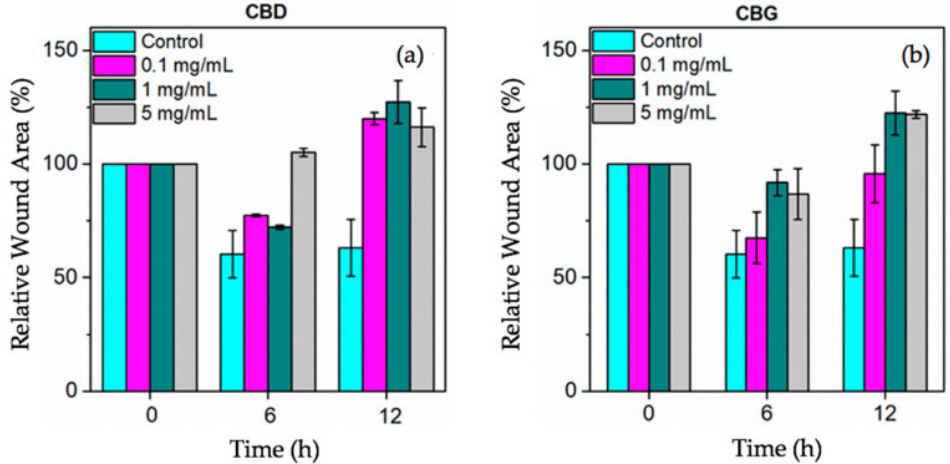
Figure 12. Relative wound area calculated by the in vitro wound healing assay for ( a ) CBD and ( b ) CBG nanoparticles in various concentrations (0.1, 1, or 5 mg/mL). Reprinted from [174].